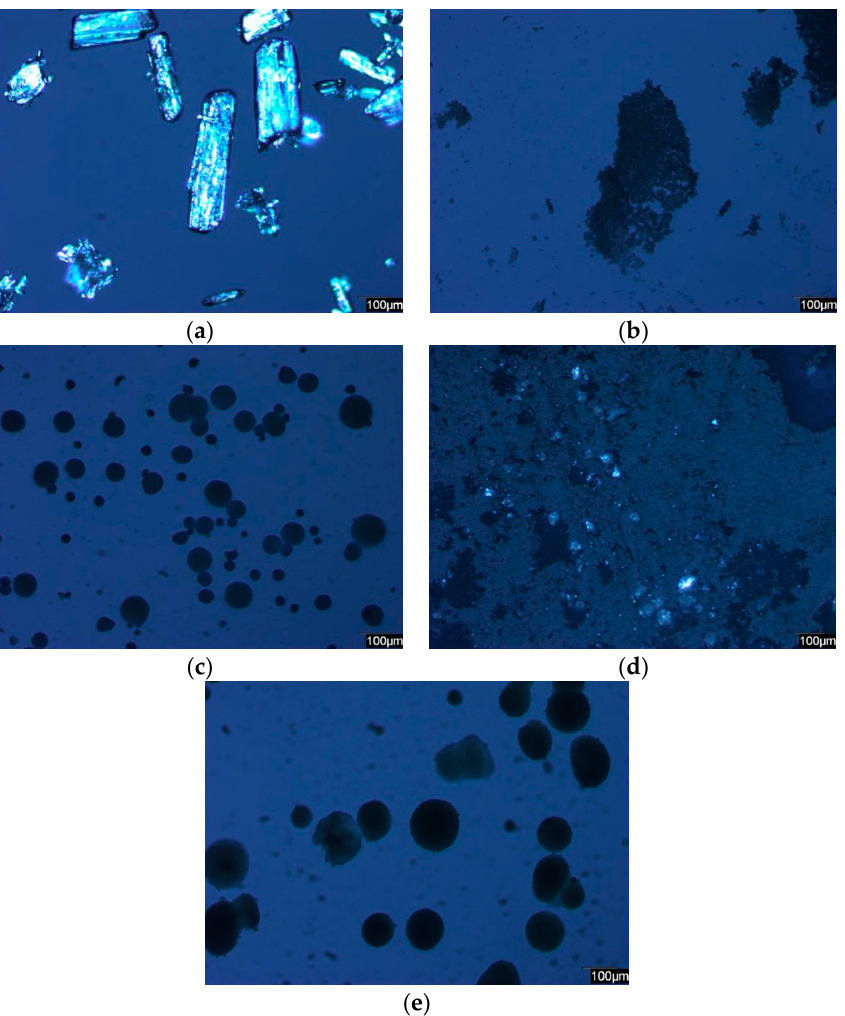
Figure 1. Representative polarized light microscopy (PLM) images of: ( a ) pure ibuprofen (IBU); ( b ) pure Syloid ® 244FP (S224FP); ( c ) pure Neusilin ® US2 (NS2); ( d ) IBU-loaded S422FP samples; ( e ) IBU-loaded NS2 samples.